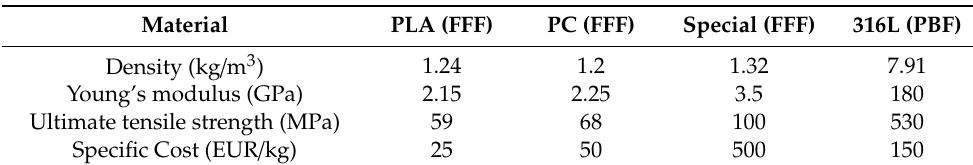
Table 1. Material comparison for additive manufacturing process: fused filament fabrication (FFF) and powder bed fusion (PBF).